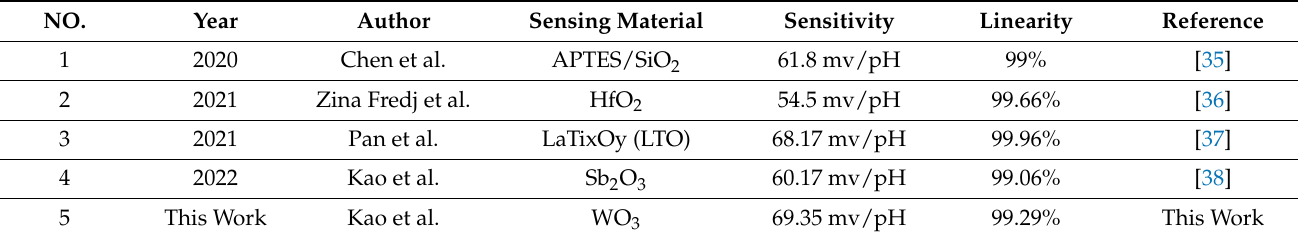
Table 1. Recent state-of-the-art EIS pH sensors.